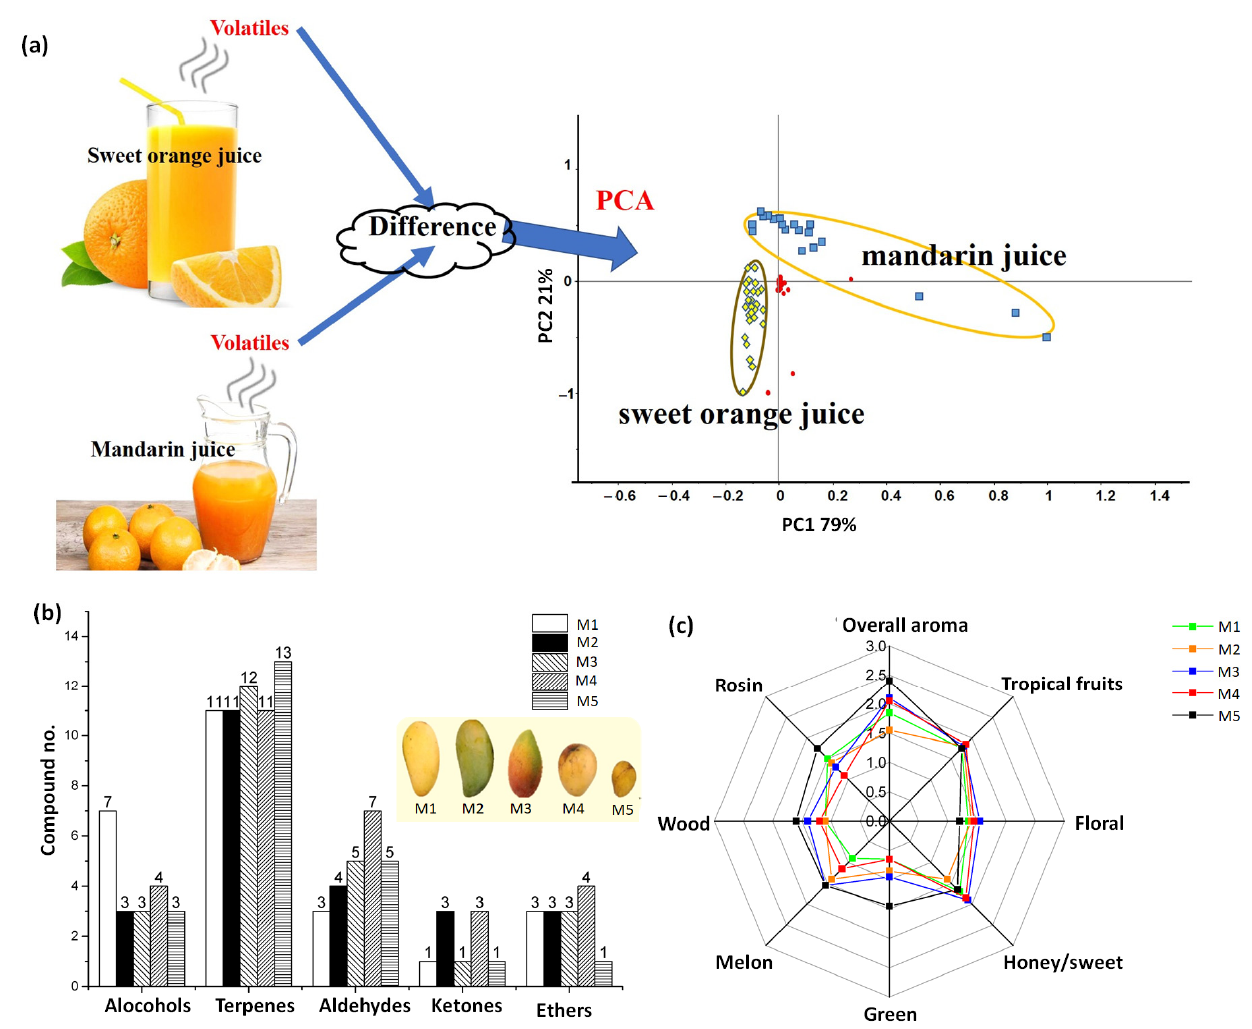
Figure 4. The detection of adulteration in sweet mango juice with mandarin juice by PCA. PCA score plot, depicting sweet orange juice, mandarin juice, and blend samples marked with green, blue, and red dots, respectively ( a ). Adapted from ref. [16]. Comparison of the bar plots of the different VOCs present in five mango samples ( b ). Adapted from ref. [58]. The spider plot showing the assignment of different aromas to each mango variety ( c ). Adapted from ref. [58].